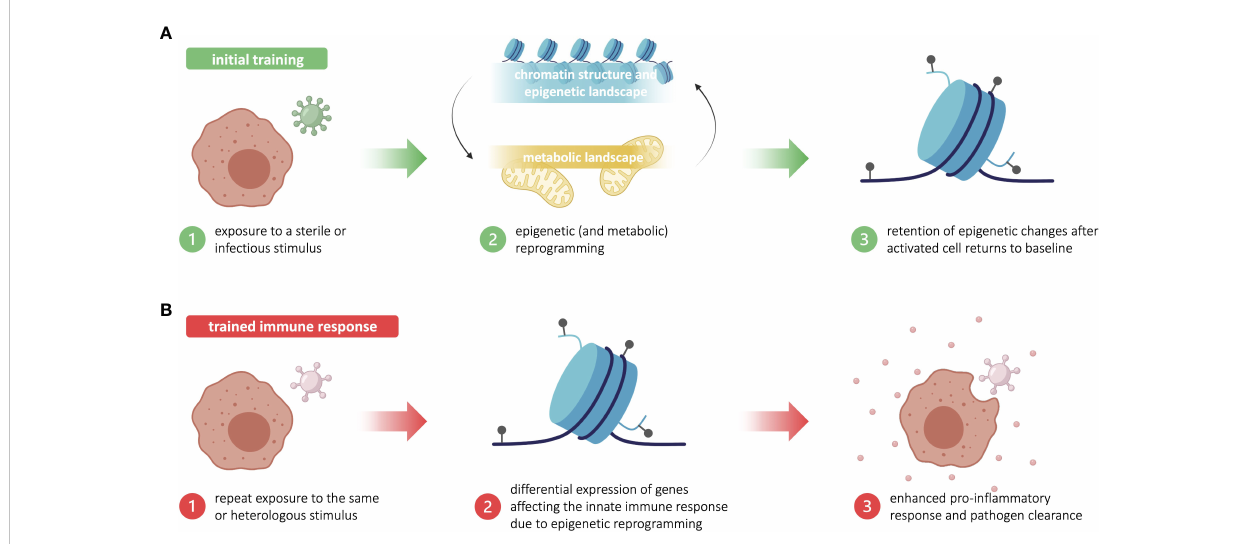
FIGURE 1 Trained immunity is based in long-standing epigenetic changes in innate immune cells. (A) Initial training begins with exposure to a sterile or infectious stimulus that triggers metabolic and epigenetic reprogramming in innate immune cells, such as myeloid and innate lymphoid cells. After the activated innate immune cells return to baseline, some epigenetic changes are retained. (B) Upon repeat exposure to the training stimulus — or a heterologous stimulus — , the lingering epigenetic marks allow for a more robust proin fl ammatory and antimicrobial innate immune response. This enhanced response to reinfection is known as trained immunity. Figure made in part using BioRender (paid